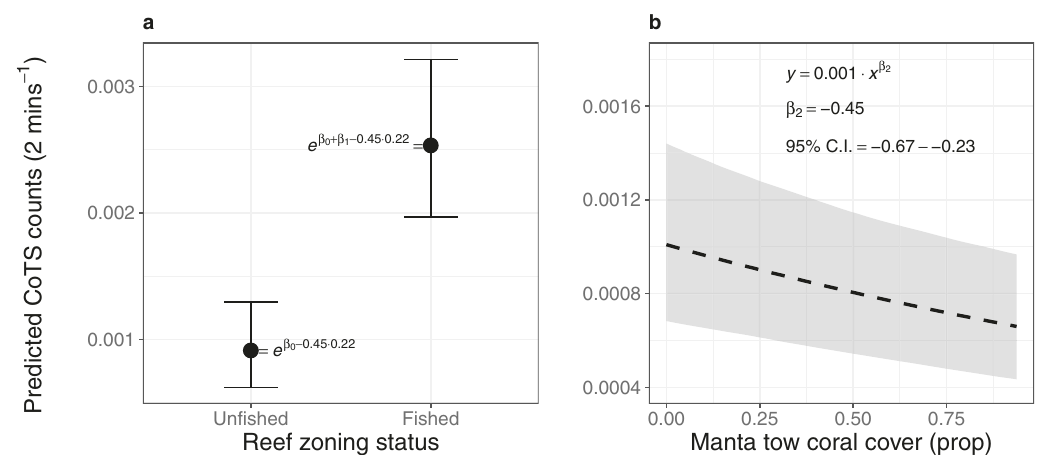
Fig. 3 Effects of no-take marine reserves and coral cover on Crown-of-Thorns Star fi sh density. Marginalised effects of a reef zoning and b coral cover on density of Paci fi c Crown-of-Thorns Star fi sh (CoTS, Acanthaster cf. solaris ) (see “ Methods ” ; Supplementary Method 4). In a , β on un fi shed reefs with a hypothetical coral cover = 0; β constitutes a direct test of whether CoTS densities are higher on fi shed reefs. In b , β 1 direct test of whether CoTS densities decrease with increasing coral cover. Mean posterior predictions presented as points ( a ) and dashed line ( b ), and 95% Bayesian credible intervals (calculated from 20,000 posterior draws) as errors bars ( a ) and grey shaded polygon ( b ). Source data are provided as a Source data fi